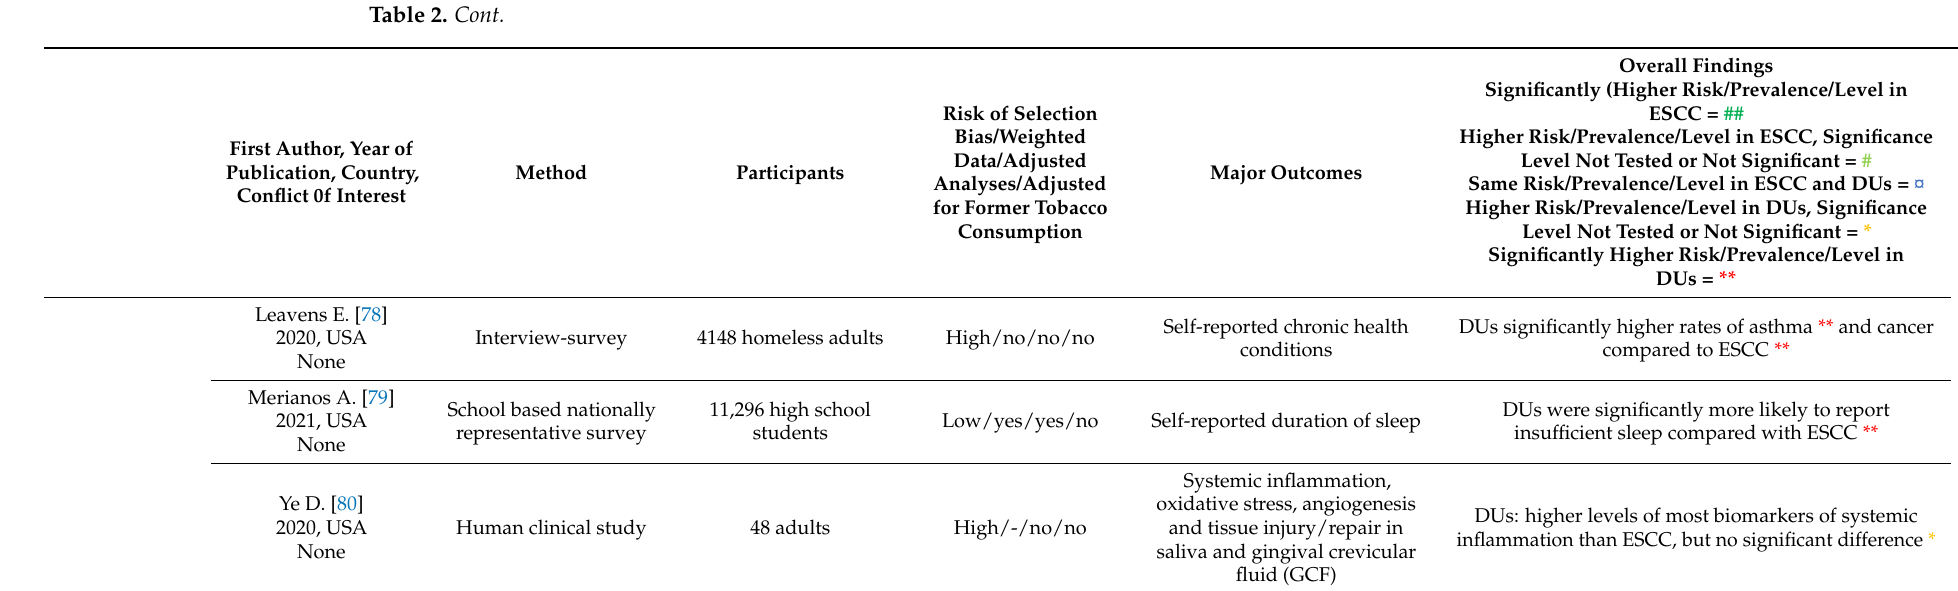
Table 2. Cross -sectional studies investigating potential harm of DUs compared to